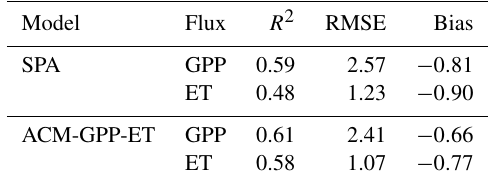
Table 4. Summary statistics for the global comparison between GPP and ET estimated by both ACM-GPP-ET and SPA from the FLUXNET2015 database. Statistics include R 2 , root mean square error (RMSE) and mean bias (model − obs). GPP units